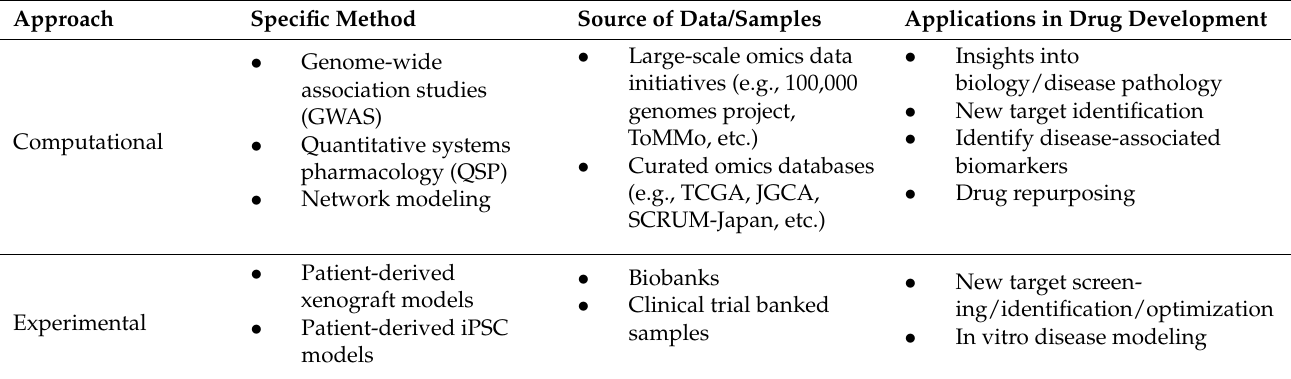
Table 1. Summary of approaches taken in biomarker and drug target